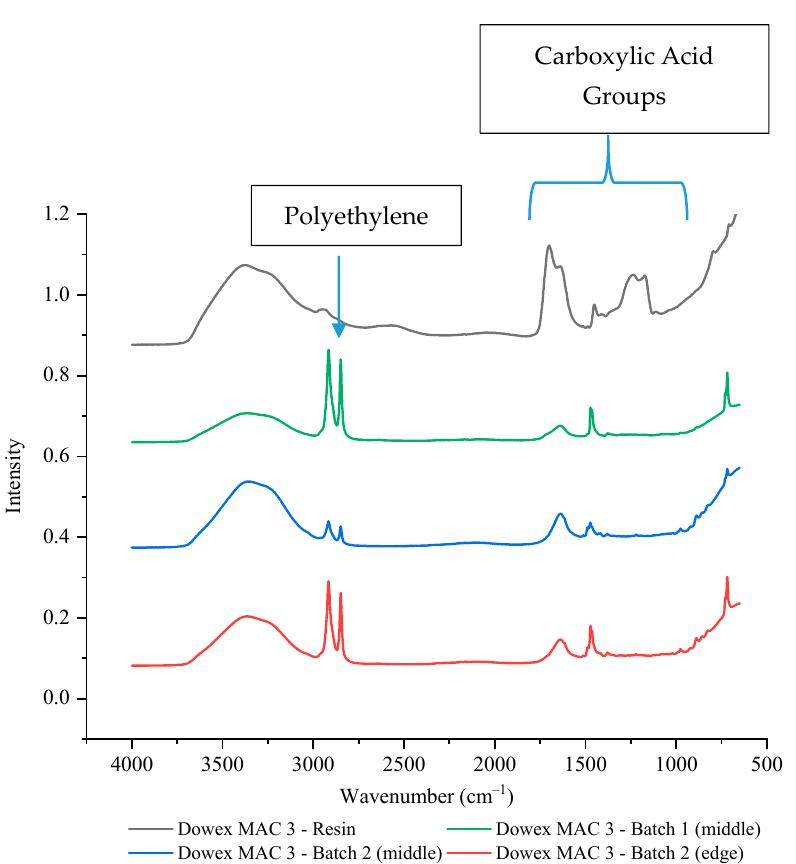
Figure 8. The FTIR-ATR spectrum of Dowex MAC 3 H + resin alone and in two different wafers.